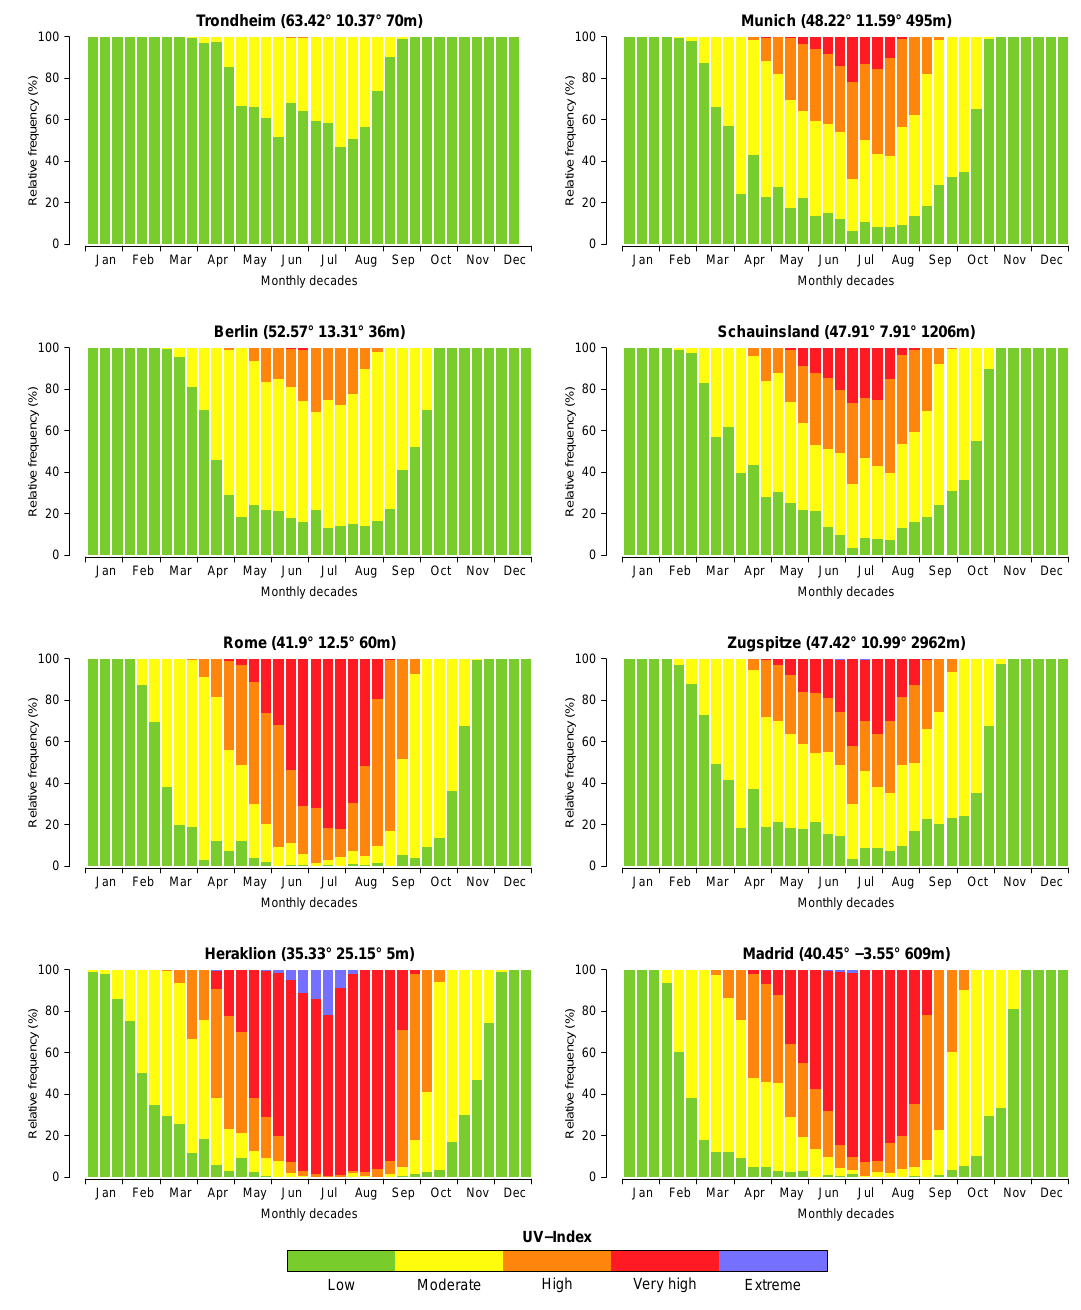
Figure 7. Relative frequency of noontime UVI all − sky classes based on 10-day decades over the time period 1983–2015 for each location based on satellite